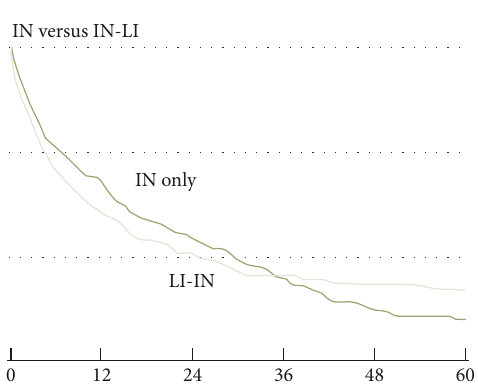
Figure 3: Graft survival after isolated intestinal transplantation ver- sus combined liver-intestine transplantation. Notes . (1) From SRTR report 2012 [19]. (2) LI-IN: combined liver-intestine transplantation; IN: isolated intestinal